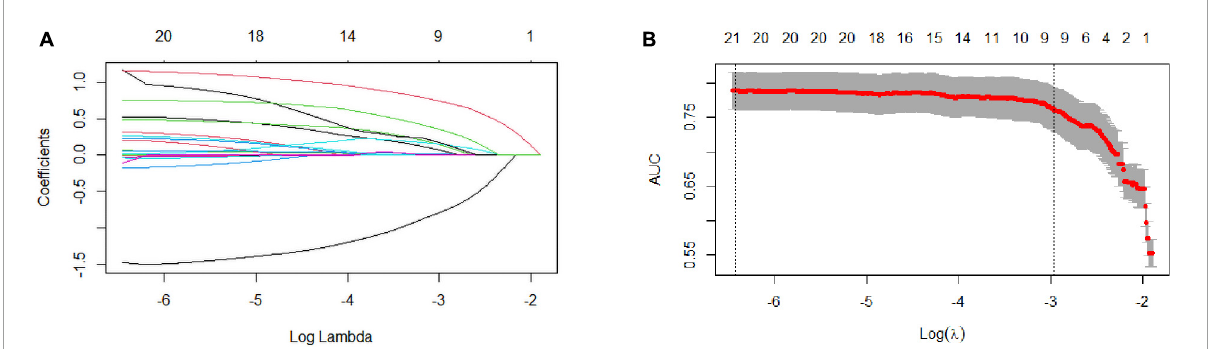
FIGURE1 Selection of coronary heart disease (CHD) risk factors using the LASSO regression method. (A) In the LASSO model, tuning parameter ( λ ) selection was performed with 10-fold cross-validation via minimum criteria. The Area Under Curve (AUC) curve is plotted against log ( λ ). Dotted vertical lines are drawn at the optimal values, as determined using the minimum criteria and 1 standard error of the minimum criteria (1-SE criteria). (B) LASSO coefficient profiles of the 24 texture features. A coefficient profile plot is produced against the log ( λ ) sequence. A vertical line is drawn at the value chosen using 1000-fold cross-validation, where optimal l resulted in 9 non-zero coefficients. LASSO, least absolute shrinkage and selection operator; SE, standard error.